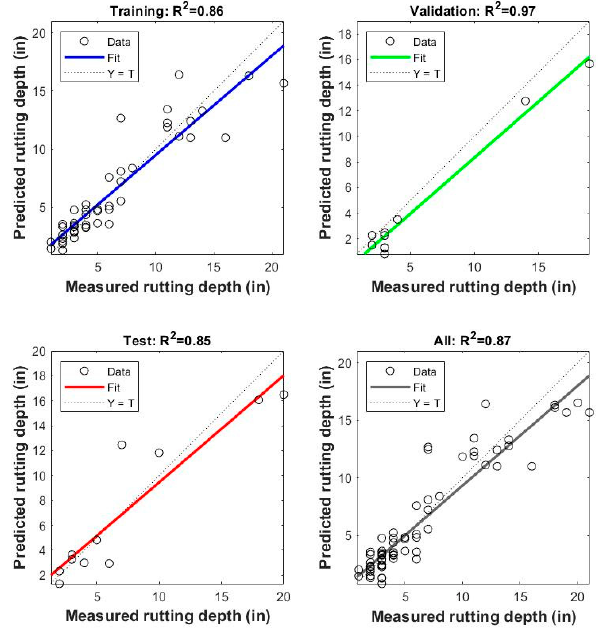
Figure 6. Regression Plot from ANN output.